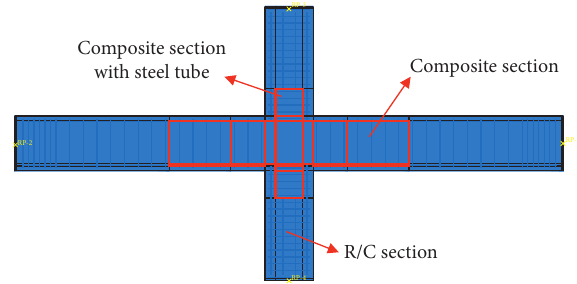
Figure 9: Partitioned 2D models for proposed connection system (hybrid